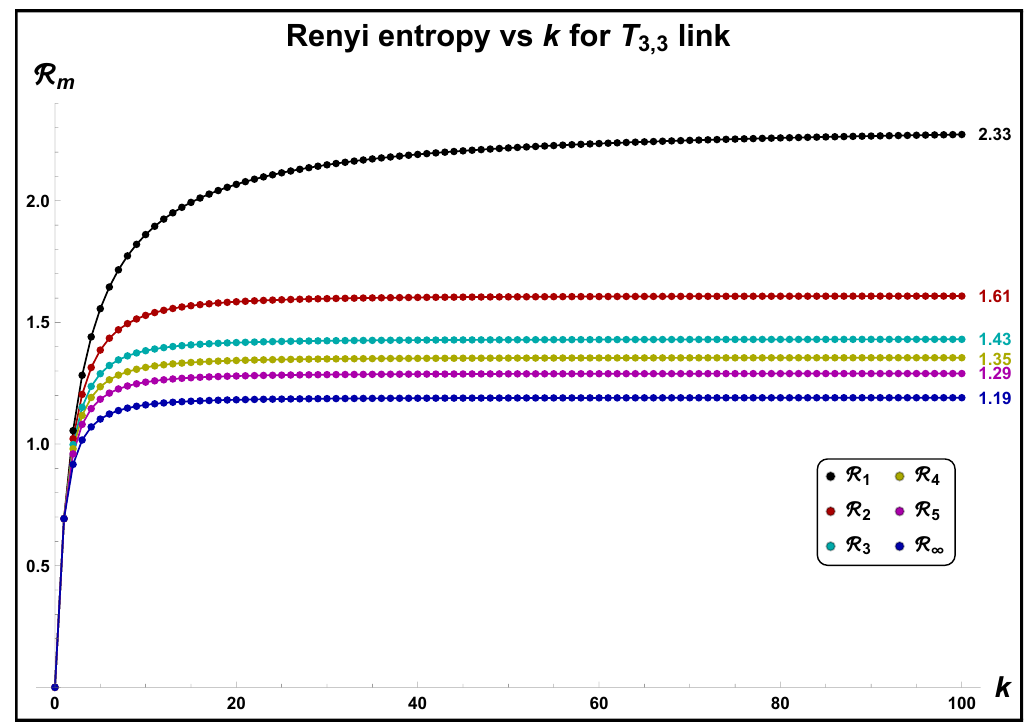
Figure 4. The variation of the Rényi entropy R m with k computed for SU (2) k group. The state under consideration is | T 3 , 3 i . The values mentioned against the plots are the approximate values (up to two decimal places) at which these entropies converge when k → ∞ . The exact asymptotic values are given in (4.21) and